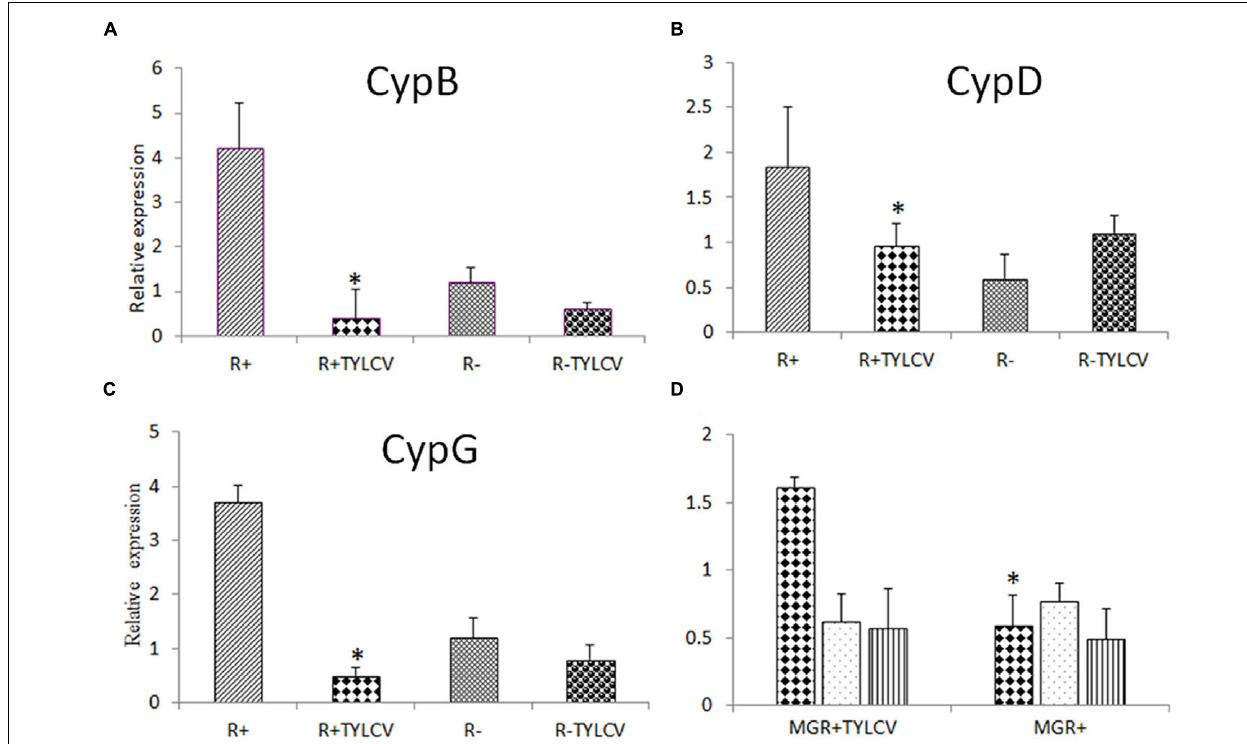
FIGURE 3 | Relative expression of cyclophilins in viruliferous and non-viruliferous whiteflies (NVBt) measured using quantitative RT-PCR (qRT-PCR), compared to the expression levels of the housekeeping gene β -actin gene. (A–C) Show relative expression of CypB, CypD, and CypG in viruliferous and NVBt, respectively, in Rickettsia -infected (R + ) and uninfected (R − ) whiteflies. Whiteflies were given acquisition access period for 10 h on Tomato yellow leaf curl virus (TYLCV)-infected plants, or healthy plants as control. (D) Relative expression of CypB (triangle columns), CypD (dotted columns), and CypG (vertical lines columns) in B. tabaci dissected midguts from viruliferous (MGR + TYLCV) and non-viruliferous (MGR + ) Rickettsia- infected whitefly B adults after a 10 h acquisition access period on TYLCV-infected and healthy tomato (HT), respectively. Data shown are the means ± standard errors of the means of data from three independent experiments. Asterisk indicate statistically significant differences with P < 0.05 between viruliferous and non-viruliferous insects.